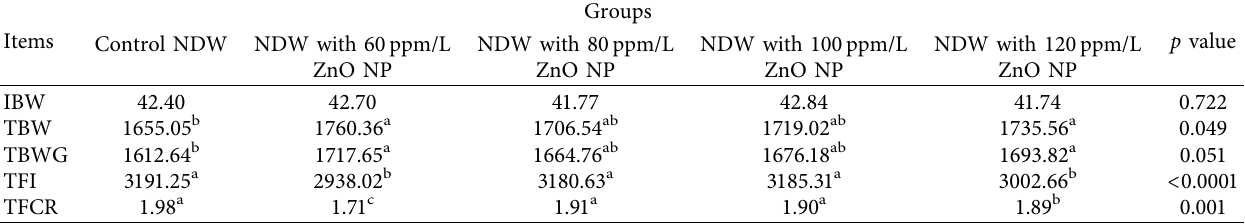
Table 1: Efect of zinc oxide nanoparticles (ZnO NPs) on broiler production at 35 days of age. Items